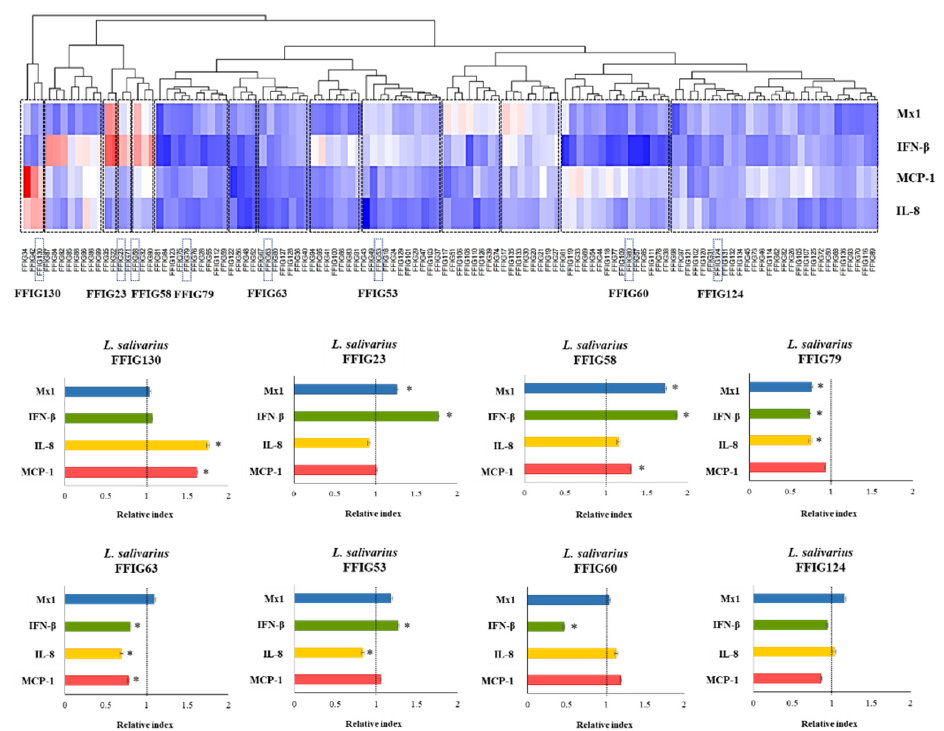
Figure 1. Modulation of toll-like receptors (TLRs) mediated innate immune responses in porcine intestinal epithelial (PIE) cells by Ligilactobacillus salivarius strains isolated from the intestinal mucosa of wakame-fed pigs. PIE cells were stimulated with the different L. salivarius strains and challenged with poly(I:C) or enterotoxigenic Escherichia coli (ETEC) to induce the activation of TLR3 and TLR4, respectively. The expressions of interferon (IFN)-β, and the antiviral factor Mx1 were analyzed by qPCR after 12 h of TLR3 activation. The expression of interleukin (IL)-8 and monocyte chemoattractant protein 1 (MCP-1) were analyzed by qPCR after 12 h of TLR4 activation. The results represent data from three independent experiments. Asterisks indicate significant differences when compared to the expression of immune factors in control PIE cells, which were set as one (* p < 0.05). Heat-map was constructed considering the fold changes relative to the control PIE cells not treated with lactobacilli and stimulated with poly(I:C) or ETEC.